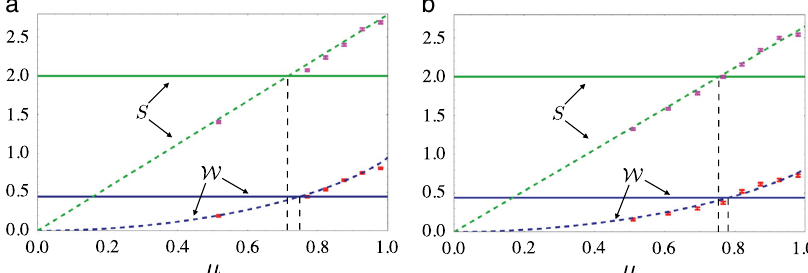
Fig. 2 Experimental results for two different resource states corresponding to cos φ ¼ 0 : 62 ( a ), and cos φ ¼ 0 : 85 ( b ) for different strengths of the depolarizing channels μ . Red dots : experimental points for W calculated from the experimental count rates measured in 30 s. Magenta dots : experimental points corresponding to the values taken by the Bell parameter, evaluated from the fully reconstructed state tomographies of the resource ρ exp . The value of cos φ is evaluated by direct inspection of the coincidence rates, averaged over all the experimental states. The error bars take into account the Poissonian statistics of the measured rates and derived from direct error propagation for W and Monte Carlo simulation for S . The green and blue dashed curves represent theoretical predictions based on state ρ , while the solid straight lines denote the entanglement thresholds and the Bell function. The dashed vertical lines identify the values of μ for which W and S cross their respective bounds